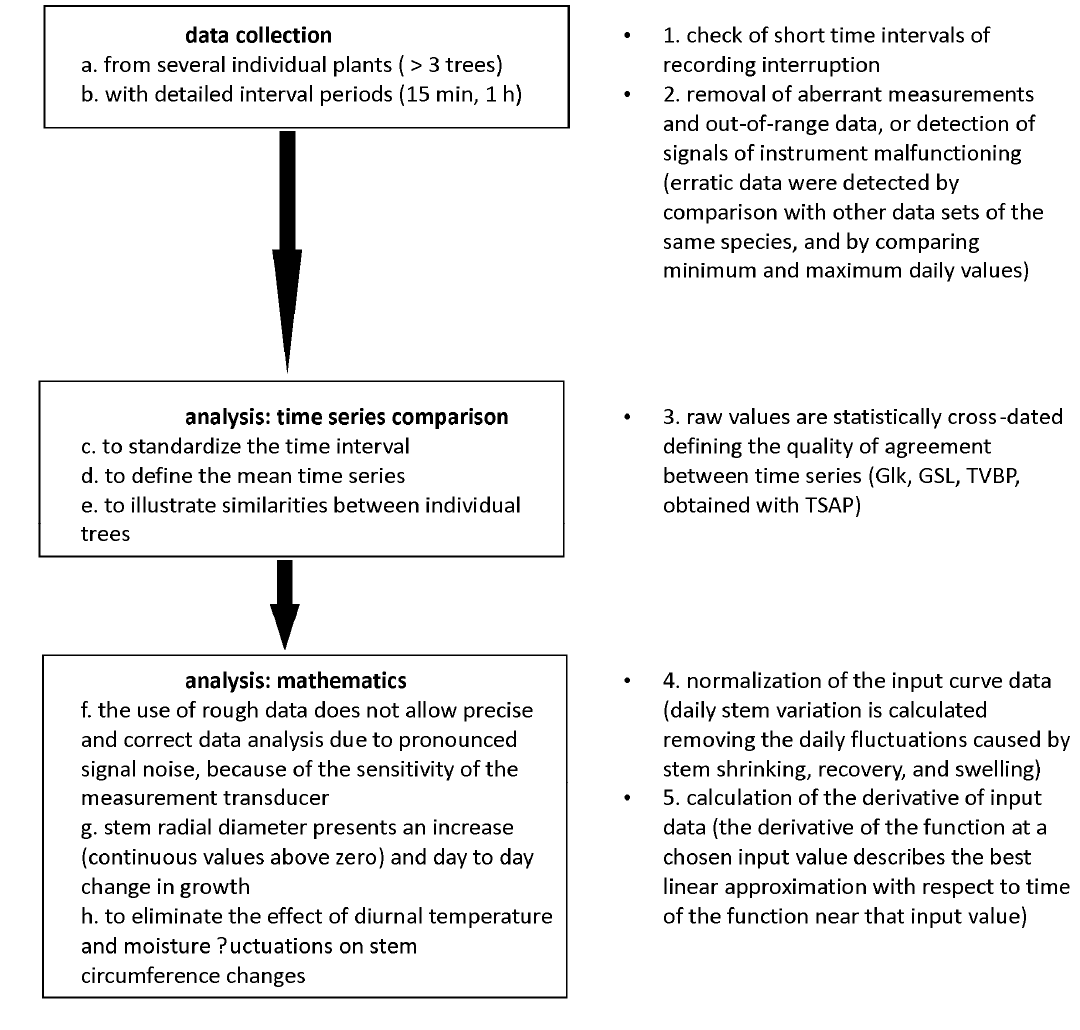
Figure 1. Conceptual diagram explaining the logical sequence of modelling approach. Changes